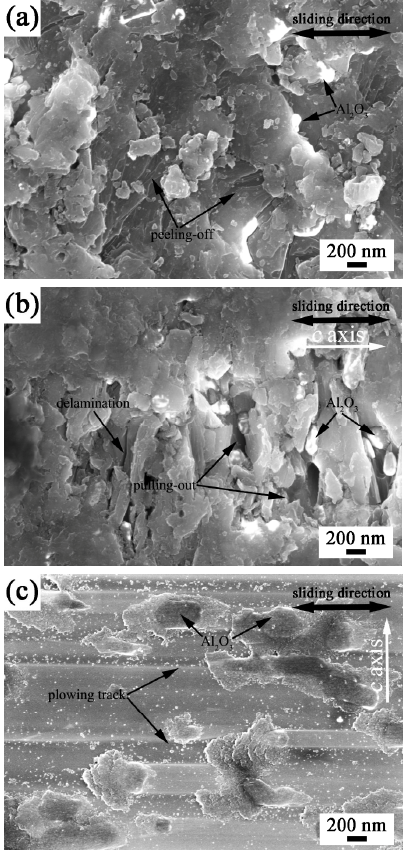
Fig. 7 Vickers indents induced by a load of 50 N on the worn surface of tailored Ti 3 AlC 2 ceramic tested under 5